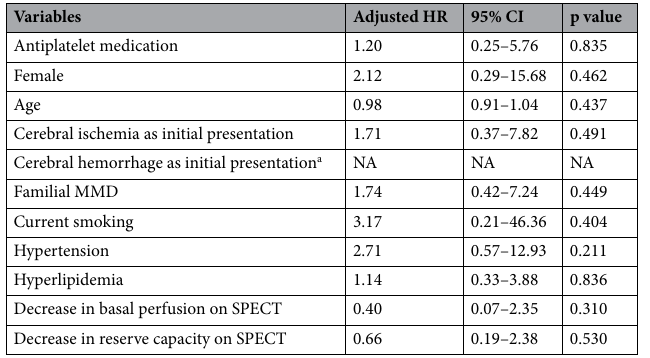
Table 3. Logistic regression analysis of symptomatic cerebral infarction associated with antiplatelet medication during the follow-up. p < 0.05 statistically significant. NA not available, MMD moyamoya disease, SPECT single photon emission computed tomography. a Event number was 0 and not estimated.